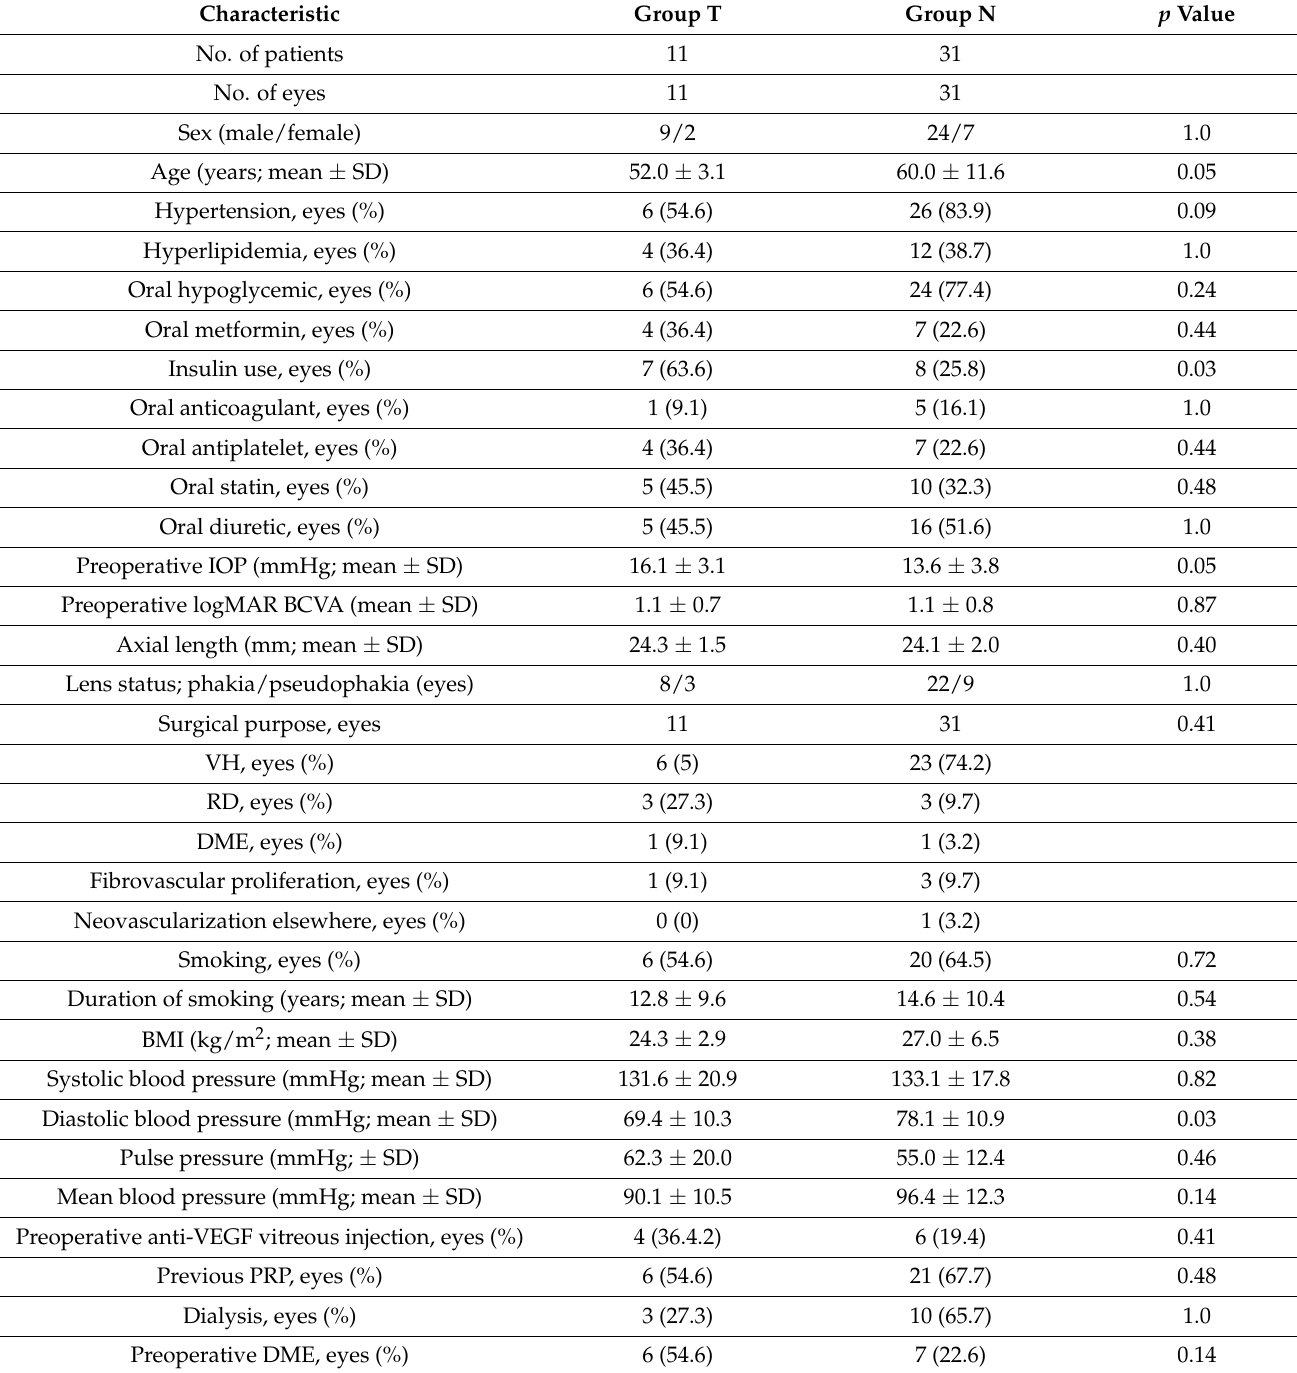
Table 1. Patient characteristics and baseline data.